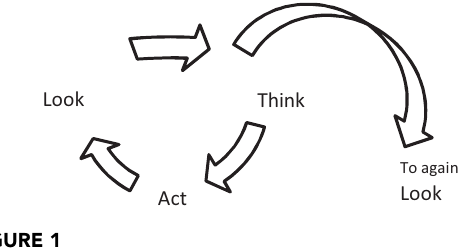
FIGURE 1 Action Research and Learning Cycle.